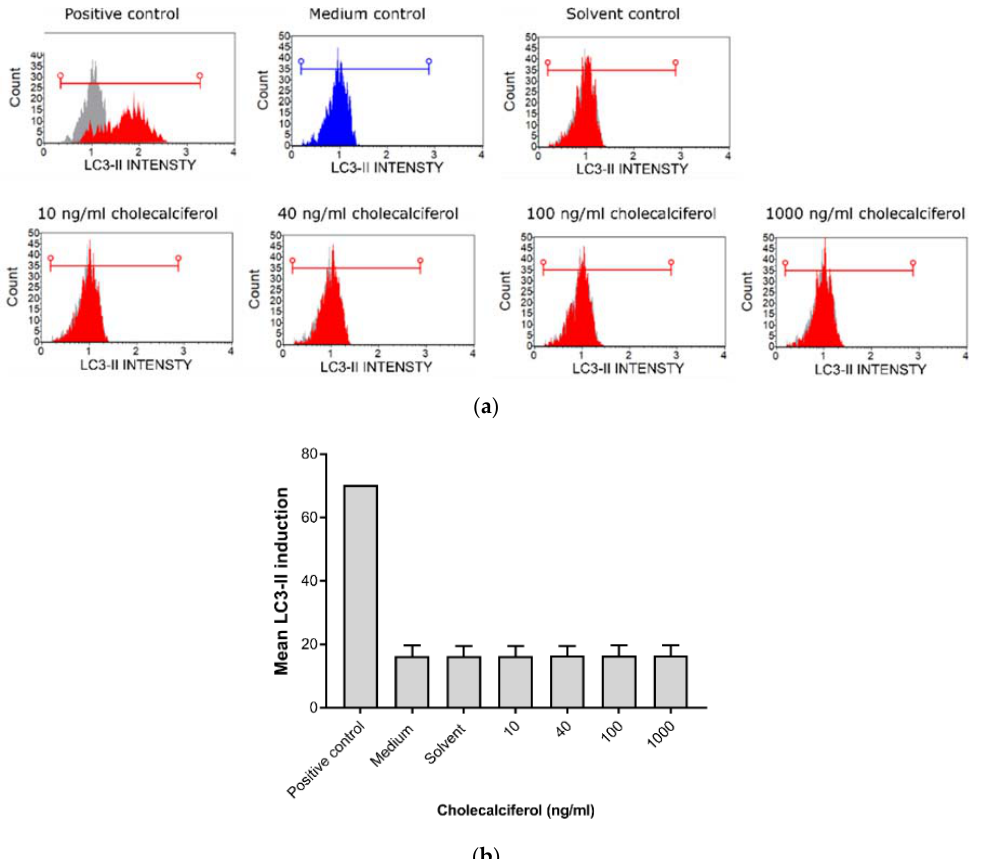
Figure 6. Analysis of autophagic cell death by the Muse™ LC3 ‐ II detection assay. ( a ) Histogram of LC3 ‐ II intensity in the control and experimental CaSki cultures. ( b ) Statistical analyses of the LC3 ‐ II induction assays in the control and experimental CaSki cultures. Cholecalciferol treatments did not cause significant changes in LC3 ‐ II expression between the control and experimental cultures. Experiments were performed in triplicate with three biological repeats. Values are expressed as mean ± SEM ( p < 0.05 was considered statistically significant).